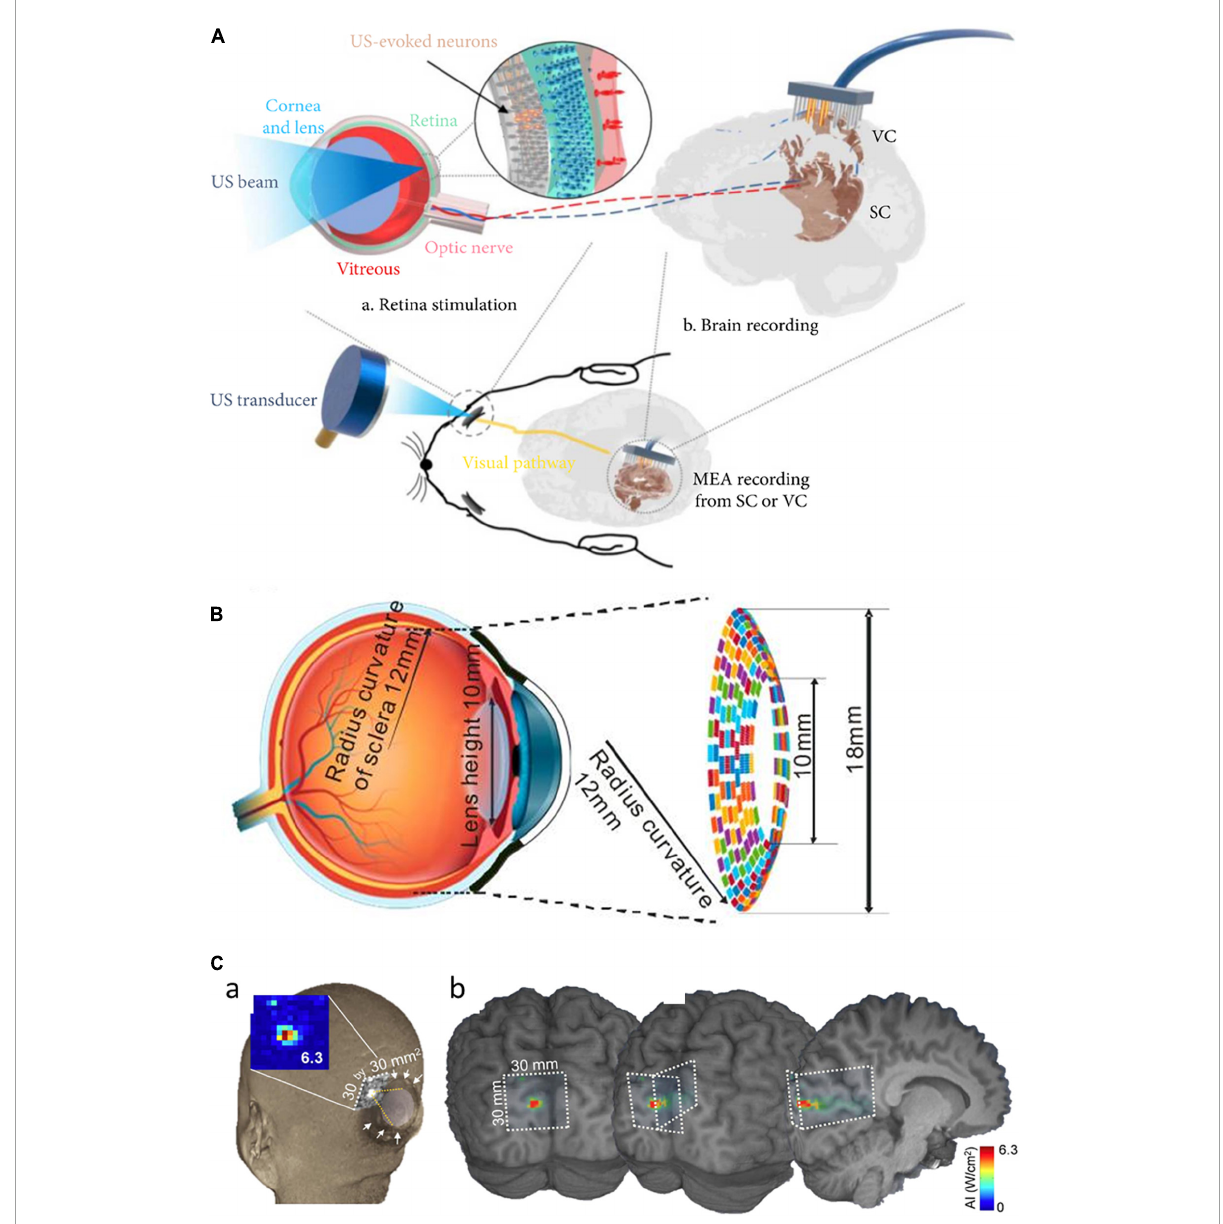
FIGURE2 Focused ultrasound treatment for visual restoration. (A) Retinal neurons were excited by ultrasound waves which lead to the generation of the neural signal. These signals are transmitted to the brain via the optic nerve and the brain activity is recorded from the visual cortex or the superior colliculus. Adapted from Qian et al. (2022). (B) The circular racing array device for ultrasonic stimulation. Adapted from Yu et al. (2019). (C) In simulated acoustic intensity profiles, the acoustic focus was effectively projected to the targeted stimulatory site localized in the calcarine fissure (a), and acoustic energy was delivered to the visual cortex (b). Adapted from Lee et al.